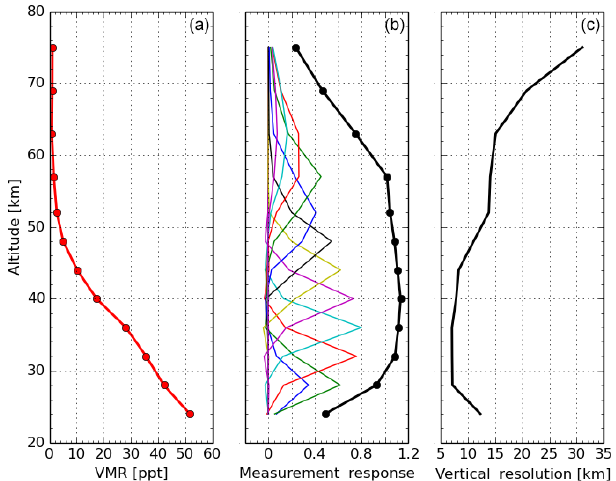
Table 3. Potential error